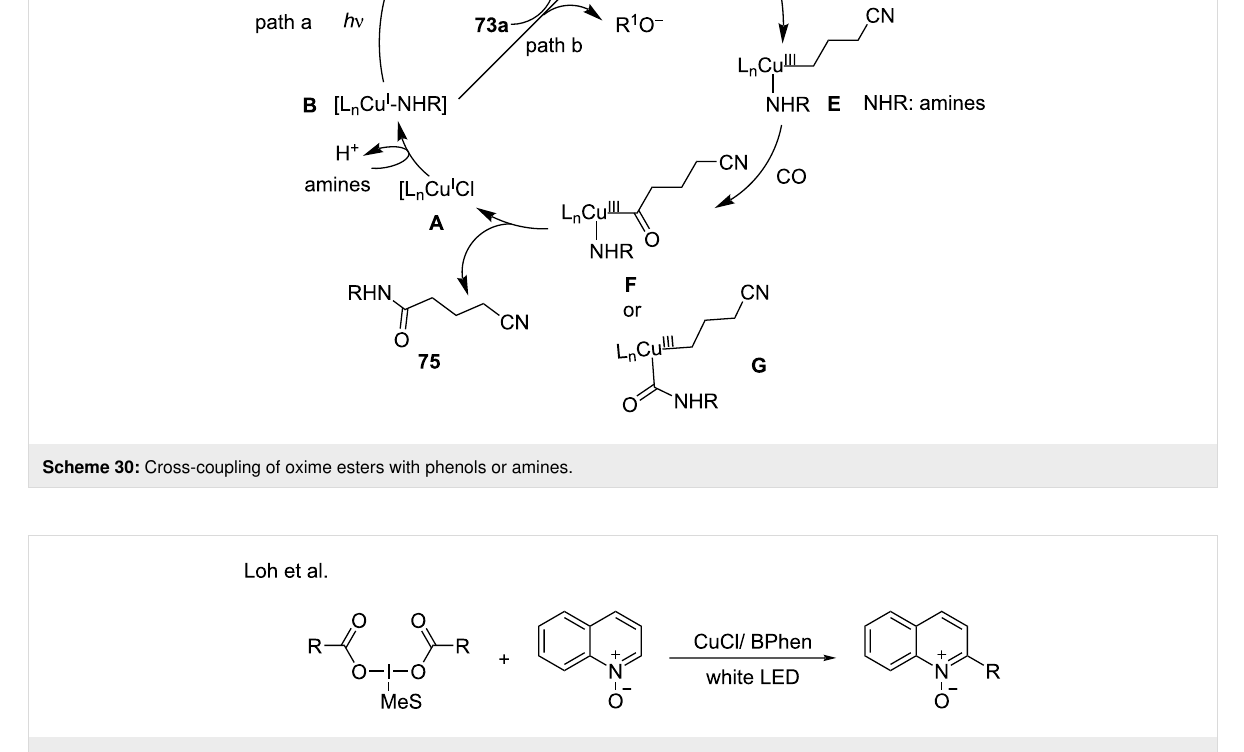
Scheme 31: Alkylation of heteroarene N